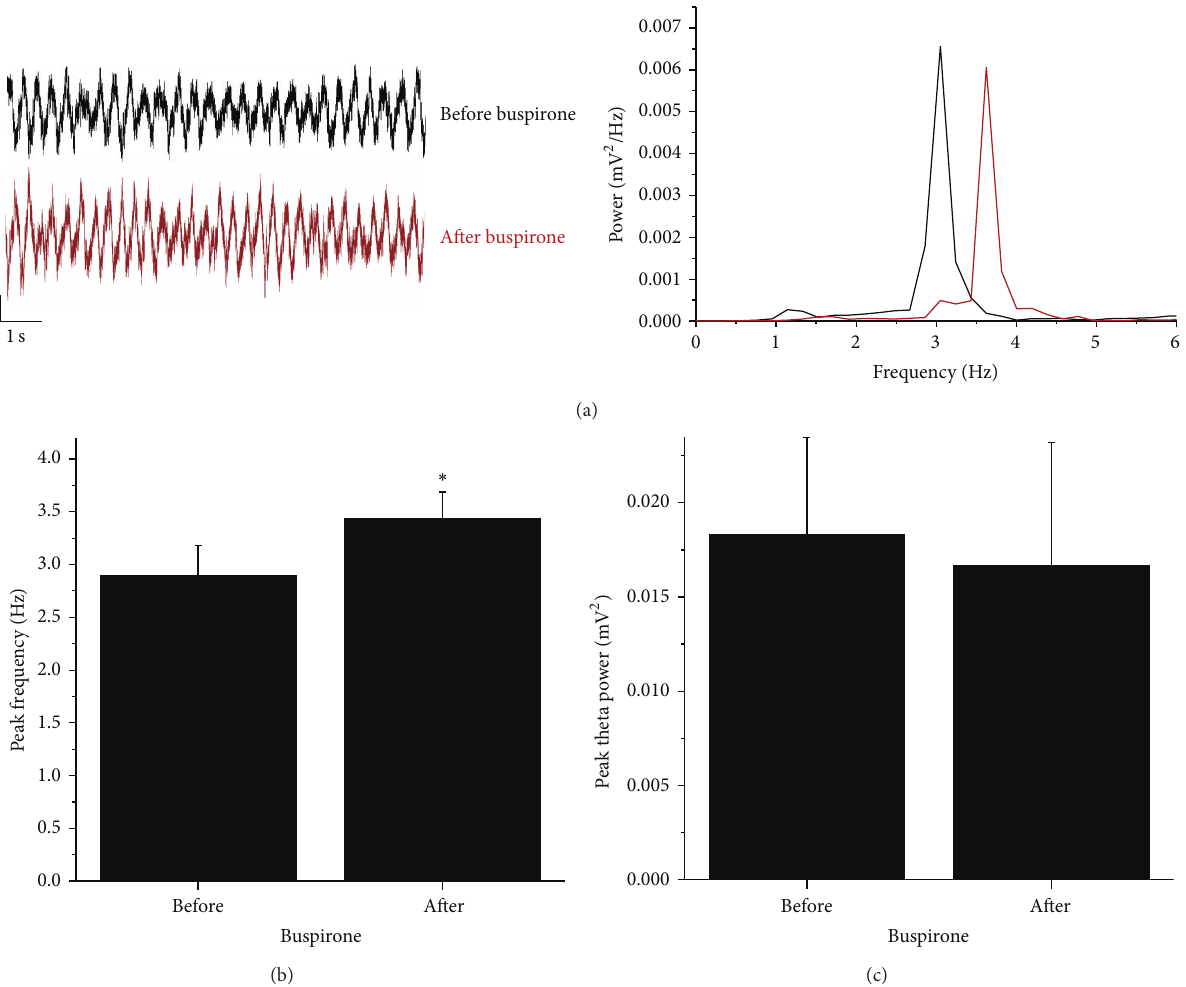
Figure 4: Representative local field potential traces showing activity before (black) and after (red) buspirone administration in the AX mice (a). Power spectra of the two illustrative traces indicate a peak shift after buspirone. Buspirone caused a slowing of evoked oscillation (b) but did not change the peak power of theta (c). Calibration bars are 1sec. and 0.3 mV. ∗ 𝑃 ≤ 0.05 , paired 𝑡 -test. on nAX mice of this low concentration of buspirone.